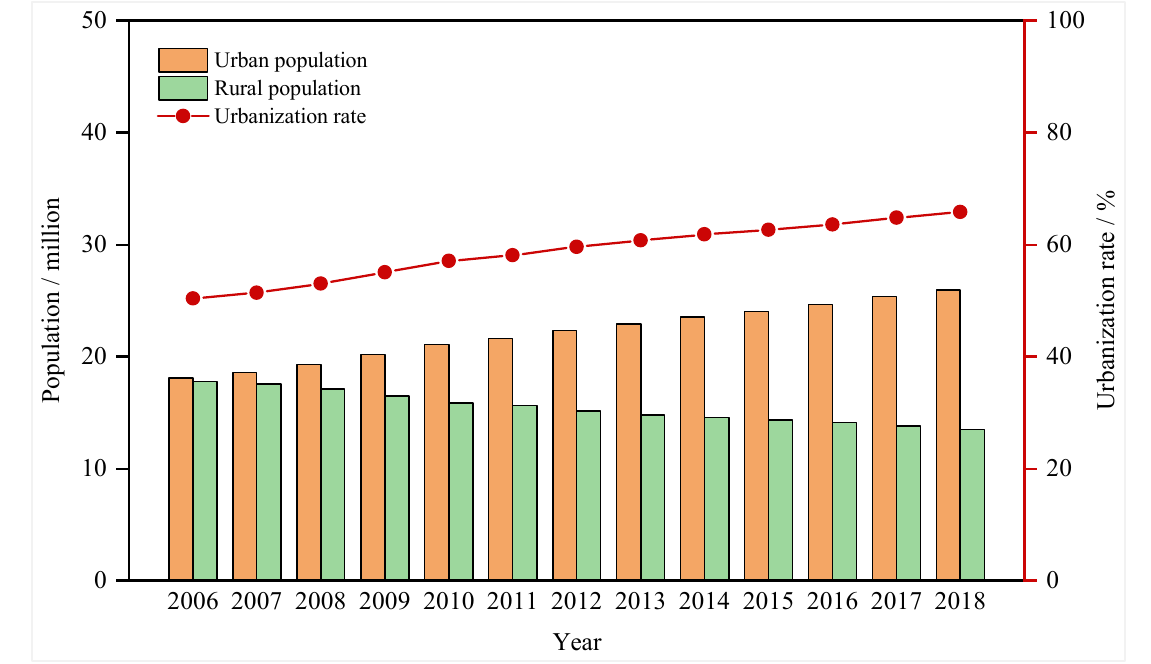
Figure 2. Population and urbanization rate in Fujian province (2006–2018).